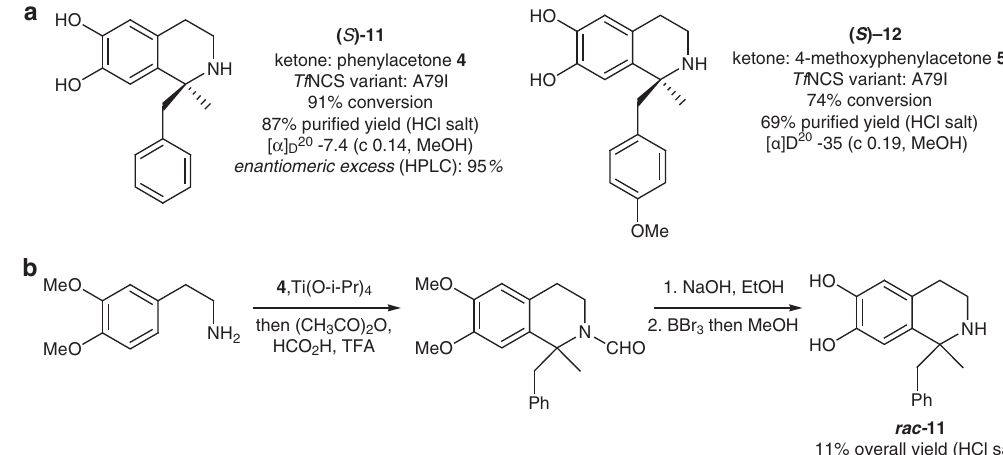
Figure 5 | Biocatalytic formation of chiral 1,1 0 -disubstituted THIQs using D 29 Tf NCS variants. ( a ) Chiral 1,1 0 -disubstituted THIQs isolated from biotransformations. ( b ) Synthetic route towards rac - 11 . See Supplementary Fig. 5 for chiral HPLC analysis, Supplementary Methods for full synthetic